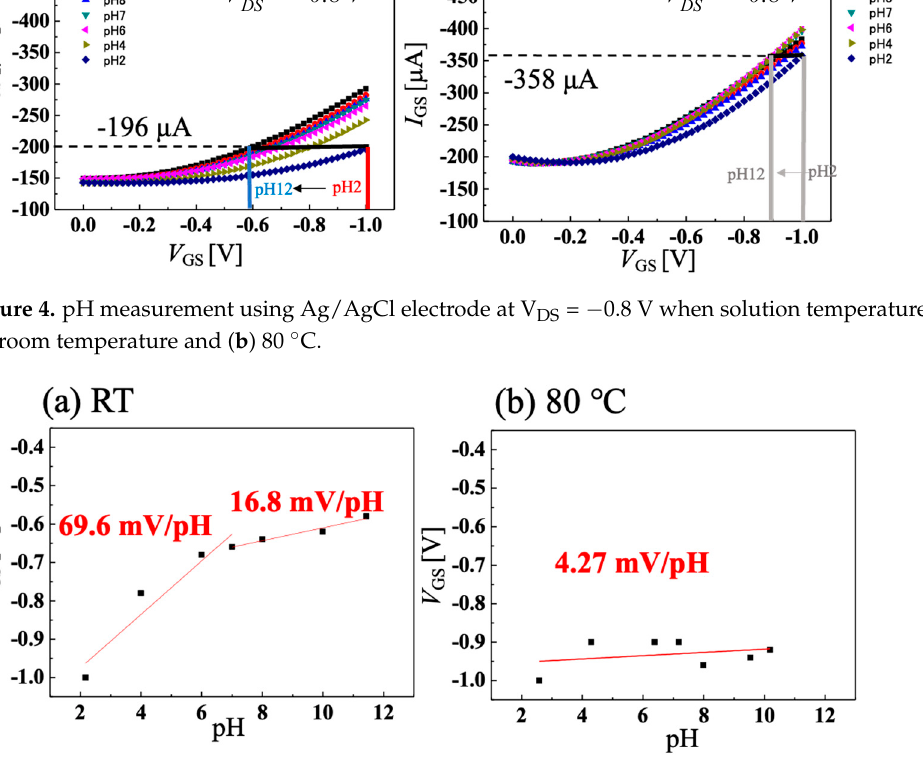
Figure 5. pH sensitivity calculated from Figure 4a,b when solution temperature is ( a ) room temper ‐ ature and ( b ) 80 °C.